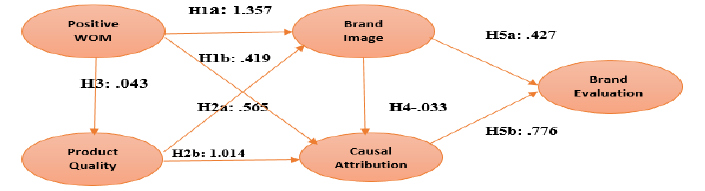
Fig. 2. The results of examining the